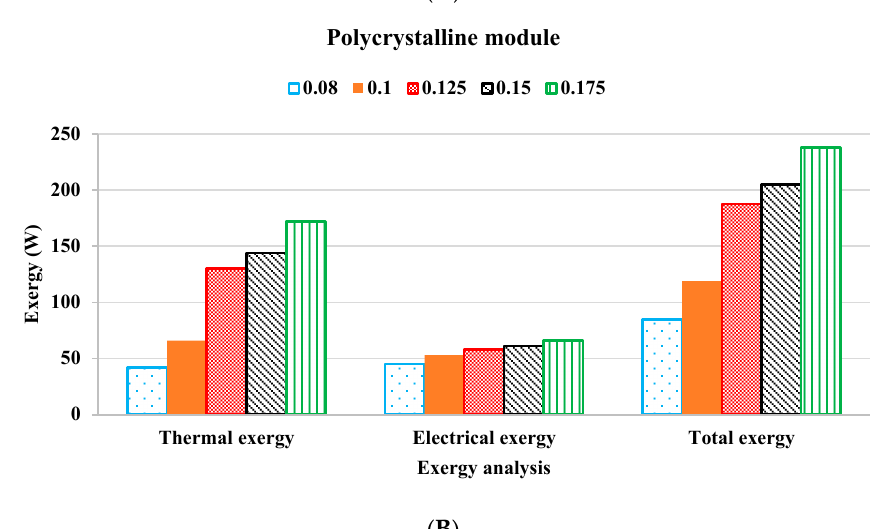
financial return from the